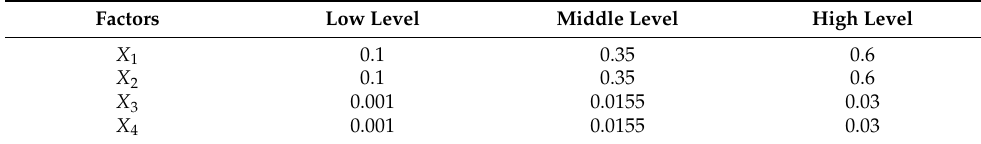
Table 5. Factors and levels of test.